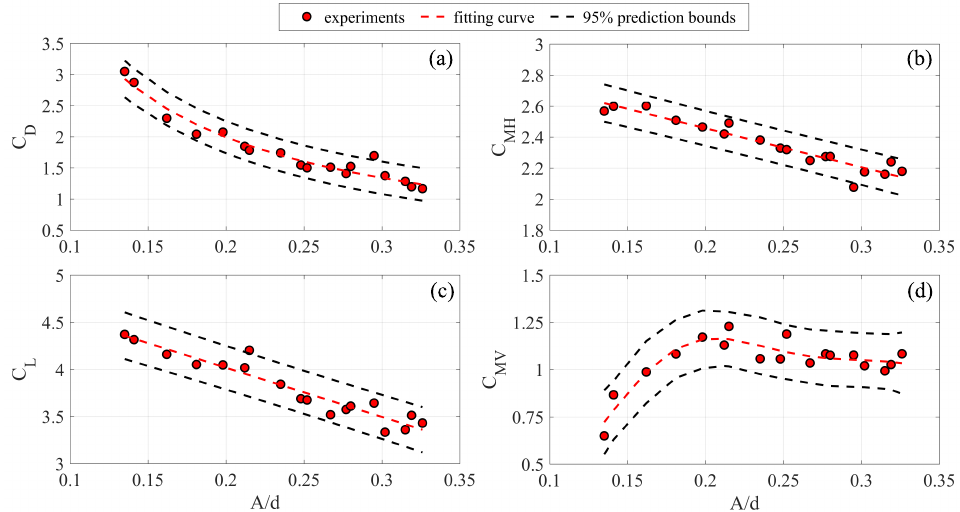
Figure 11. Hydrodynamic coefficients vs. A / d . ( a ) C D ; ( b ) C MH ; ( c ) C L ; ( d ) C MV